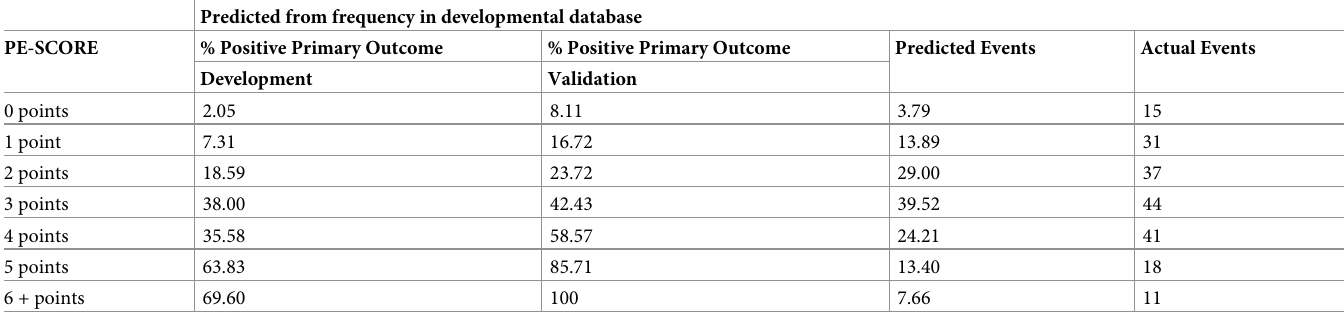
Table 4. Number of predicted and actual events in validation database.